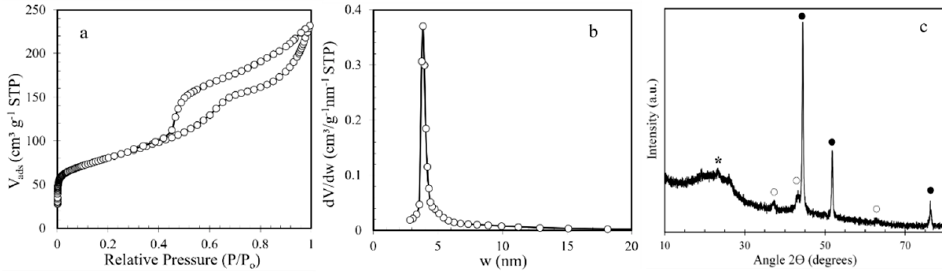
Figure 2. ( a ) Nitrogen adsorption − desorption isotherm, ( b ) PSD of TPNi ( 𝑤 —pore width in nm), and ( c ) XRD profile of TPNi (* amorphous carbon, ○ nickel oxide, ● metallic nickel).